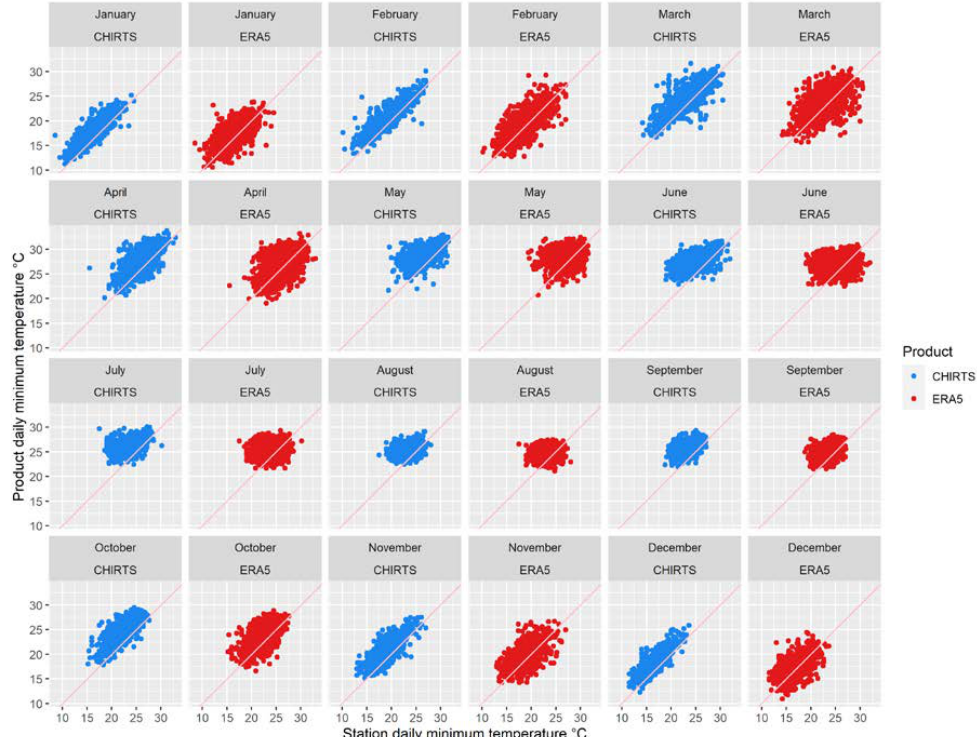
Figure 5. RMSE between station minimum temperatures and CHIRTS (blue), ERA5 (red) and ERA5- Land (green) for each month at the stations in Niger and Ghana ( a – d ) and Kenya, Tanzania and Zambia ( e – h ).